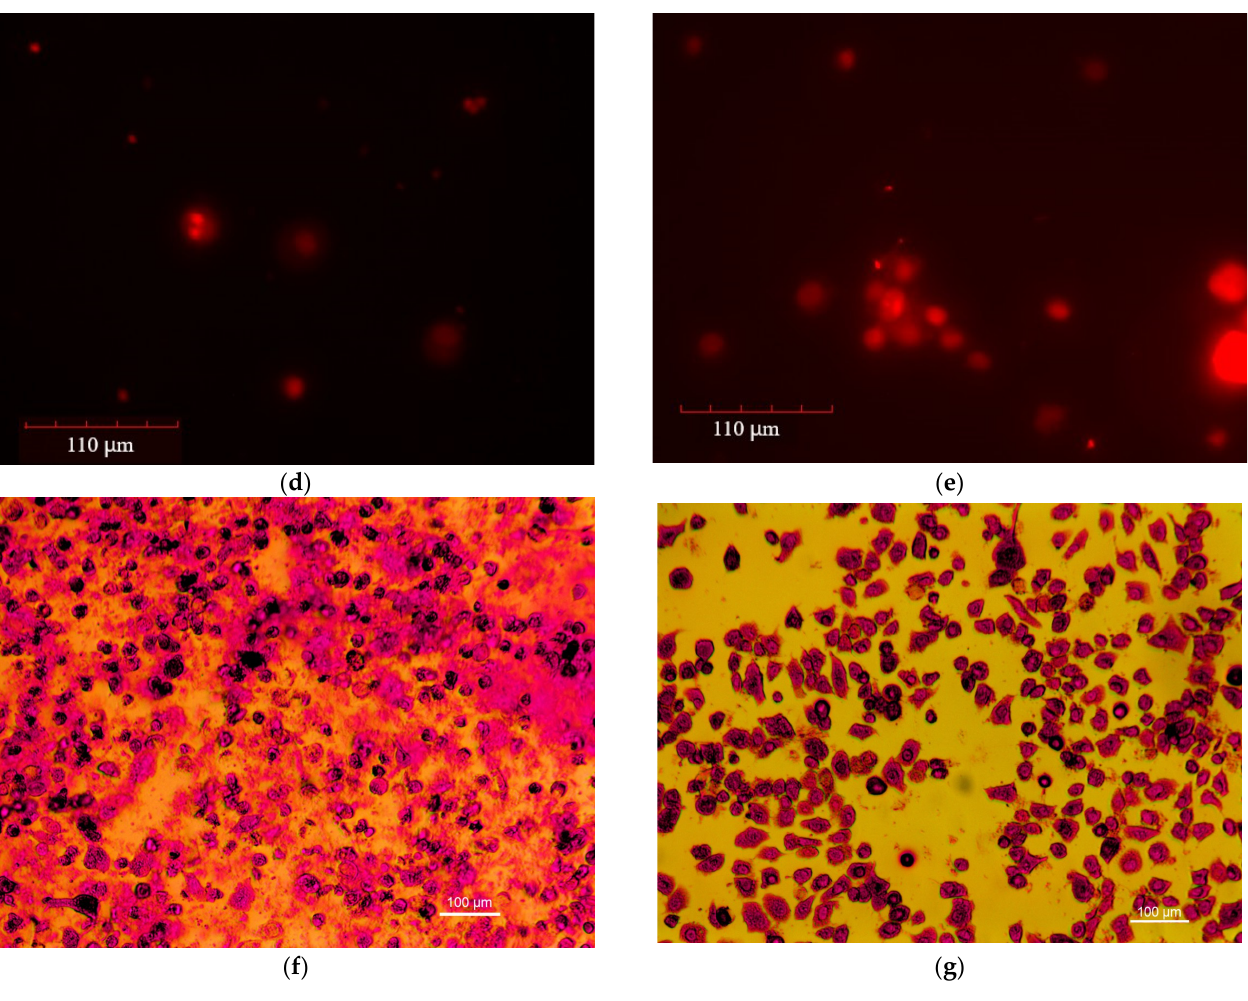
Figure 11. Fluorescence images of A549 after 2 h incubation with Dox 10 µg/mL: ( a ) free in Dox red channel; ( b , c ) in micelles Chit5-MUA-20 in Dox red channel and eosin magenta channel, respectively; ( c ) with EG; ( d ) in micelles Chit5-MUA-20 with EG in Dox red channel. λ exci = 500–560 nm. ( e ) Fluorescence images of A549 after 2 h of incubation with Dox 10 µg/mL in eosin-labelled micelles Chit5-MUA-20: eosin (magenta) channel. λ exci = 460–490 nm. The scale segment is 110 µm. ( f , g ) Optical images of A549 after 72 h incubation with Dox 1 mg/mL free and in micelles Chit5- MUA-20, respectively.